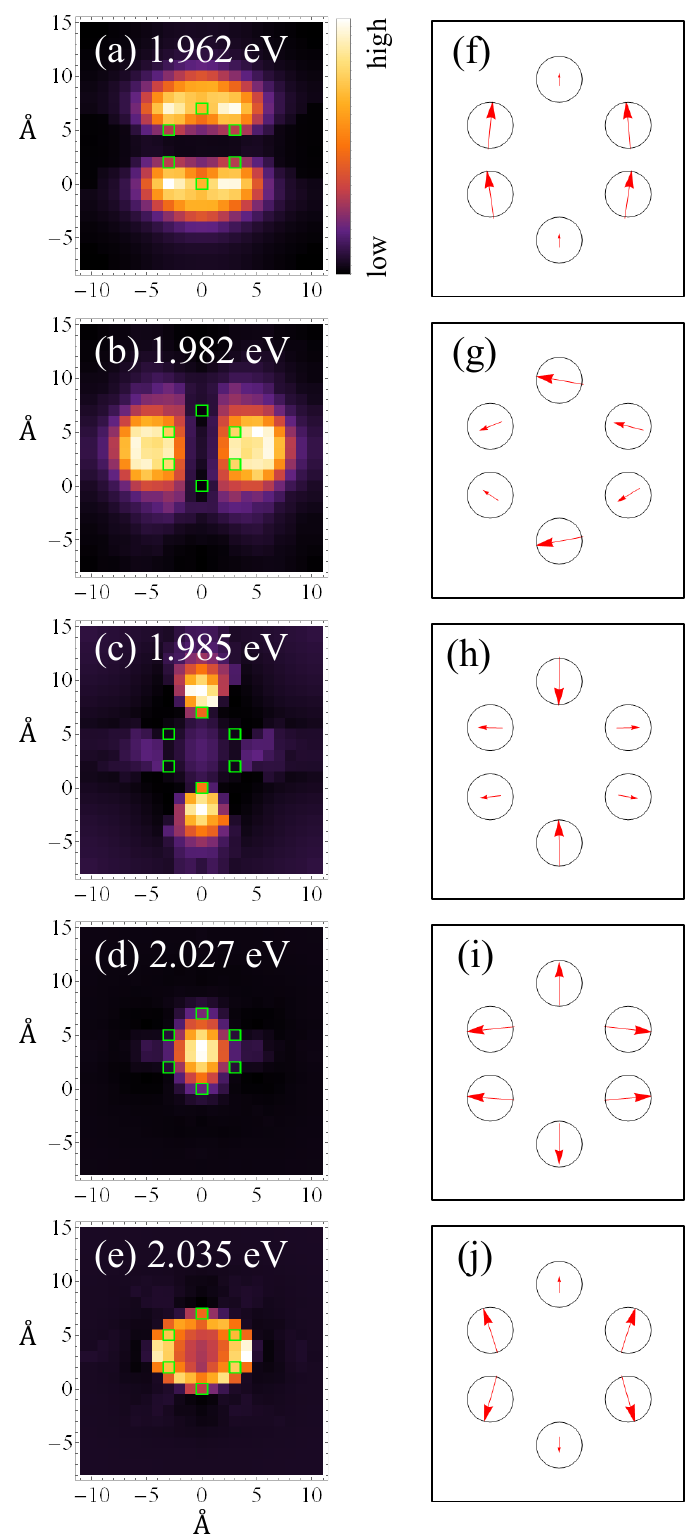
Figure 3. ( a – e ) are PiFM images for the resonance states. The green squares represent the positions of each element of the six-membered molecule. ( f – j ) represent the dipole structures of the molecule corresponding to the PiFM image above. The circles represent the elements of the six-membered molecule, and the red arrows represent the polarization